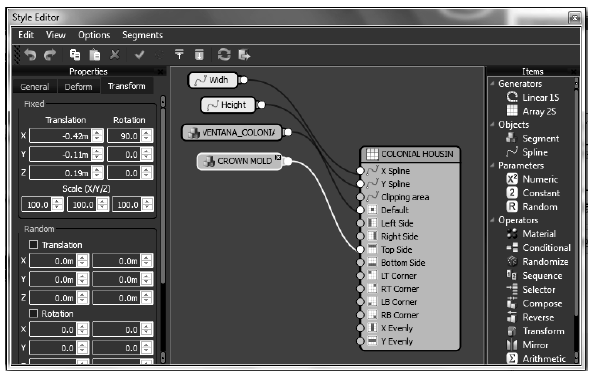
Figure 9. Detail of the applied style. The window style parameters were: length, width, window and crown molding. These were adjusted taking into account the typical historic architectural features, such as the height of the second floor, usually larger than first floor.